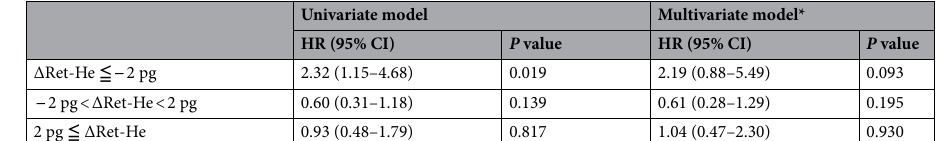
Univariate model Multivariate model*